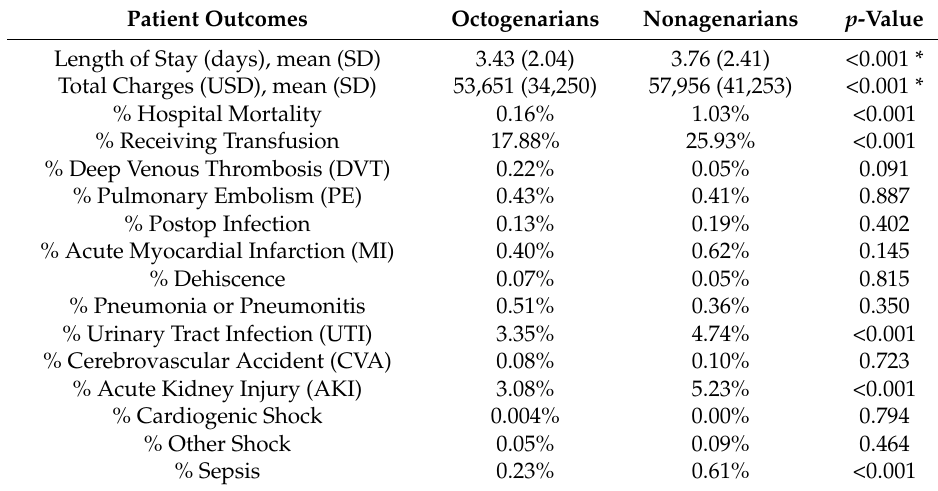
Table 2. Comparing the outcomes and complications of patients undergoing primary total knee arthroplasty between octogenarians and nonagenarians. Healthcare Cost and Utilization Project—Nationwide Inpatient Sample, 2010–2014. Patient Outcomes Octogenarians Nonagenarians p -Value Length of Stay (days), mean (SD) 3.43